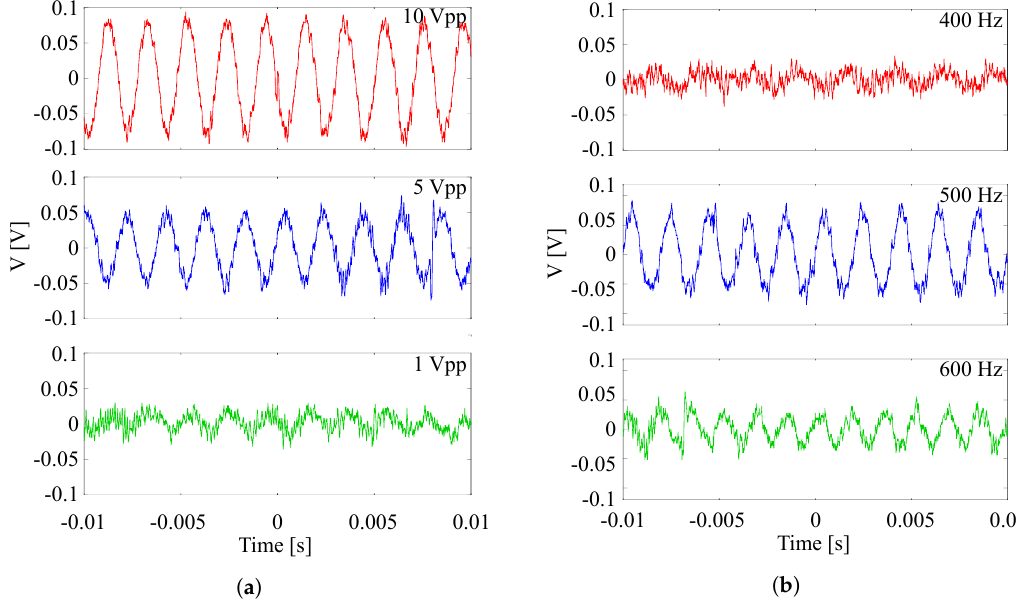
Figure 25. Amplified output signal on the oscilloscope for a dynamic strain measurement with an EpoCore GMR grating sensor foil for ( a ) different driving voltages of the loudspeaker driver and frequency fixed at 490 Hz and for ( b ) different frequencies and signal strength fixed at 10